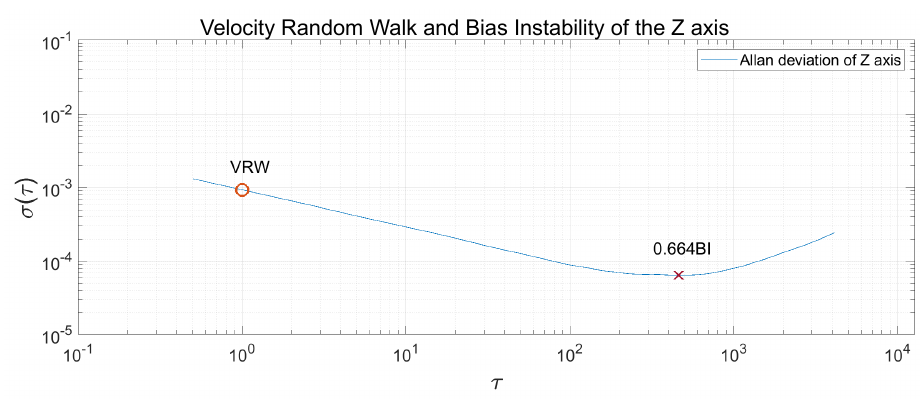
Figure 14. Velocity random walk and bias instability of the sensor y -axis.